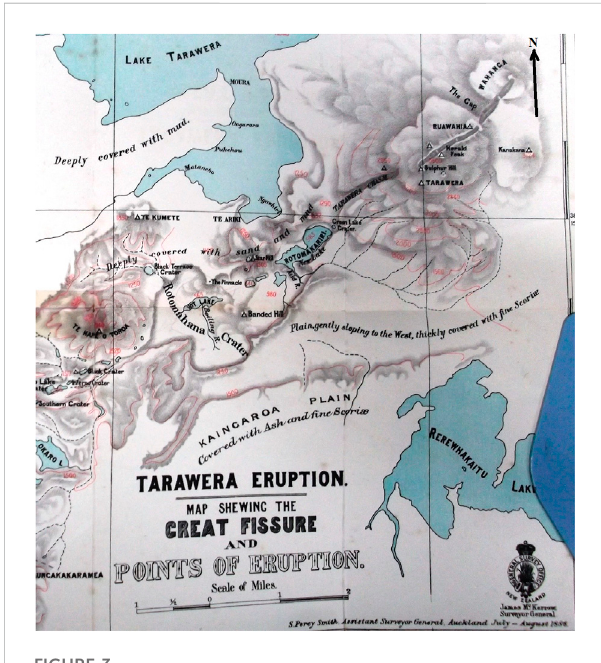
FIGURE 3 Rotomahana Basin in July − August 1886 (Smith,